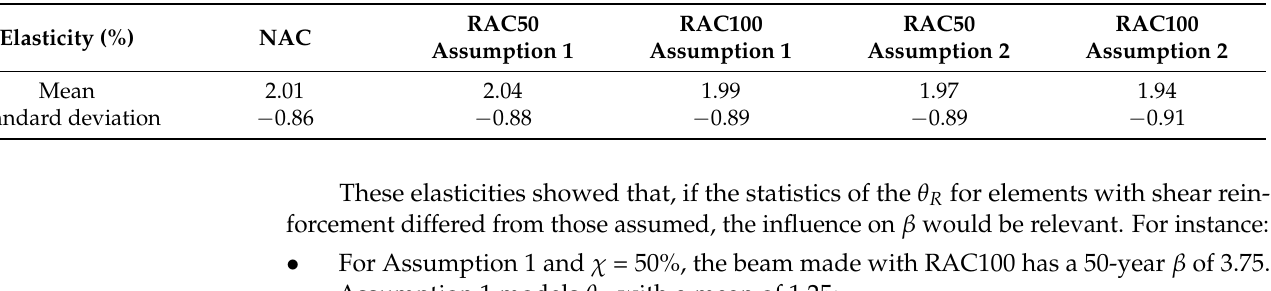
Table 10. Elasticities of θ VR , with shear for χ = 0. EN1992 [31] and prEN1992 [32]. Assumption 1: γ RAC 50 = 1.00;